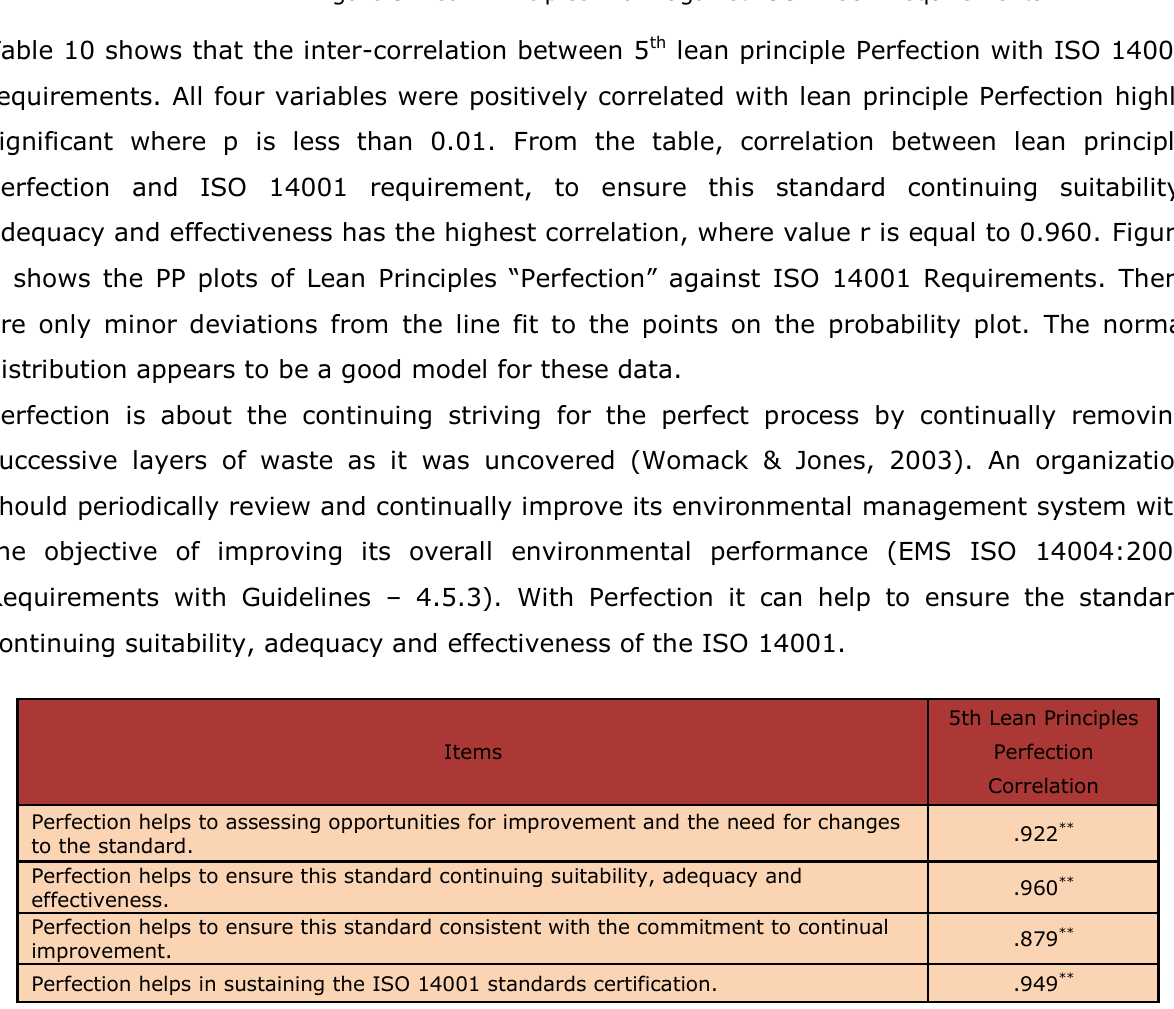
Figure 5. Lean Principles “Pull” against ISO 14001 Requirements